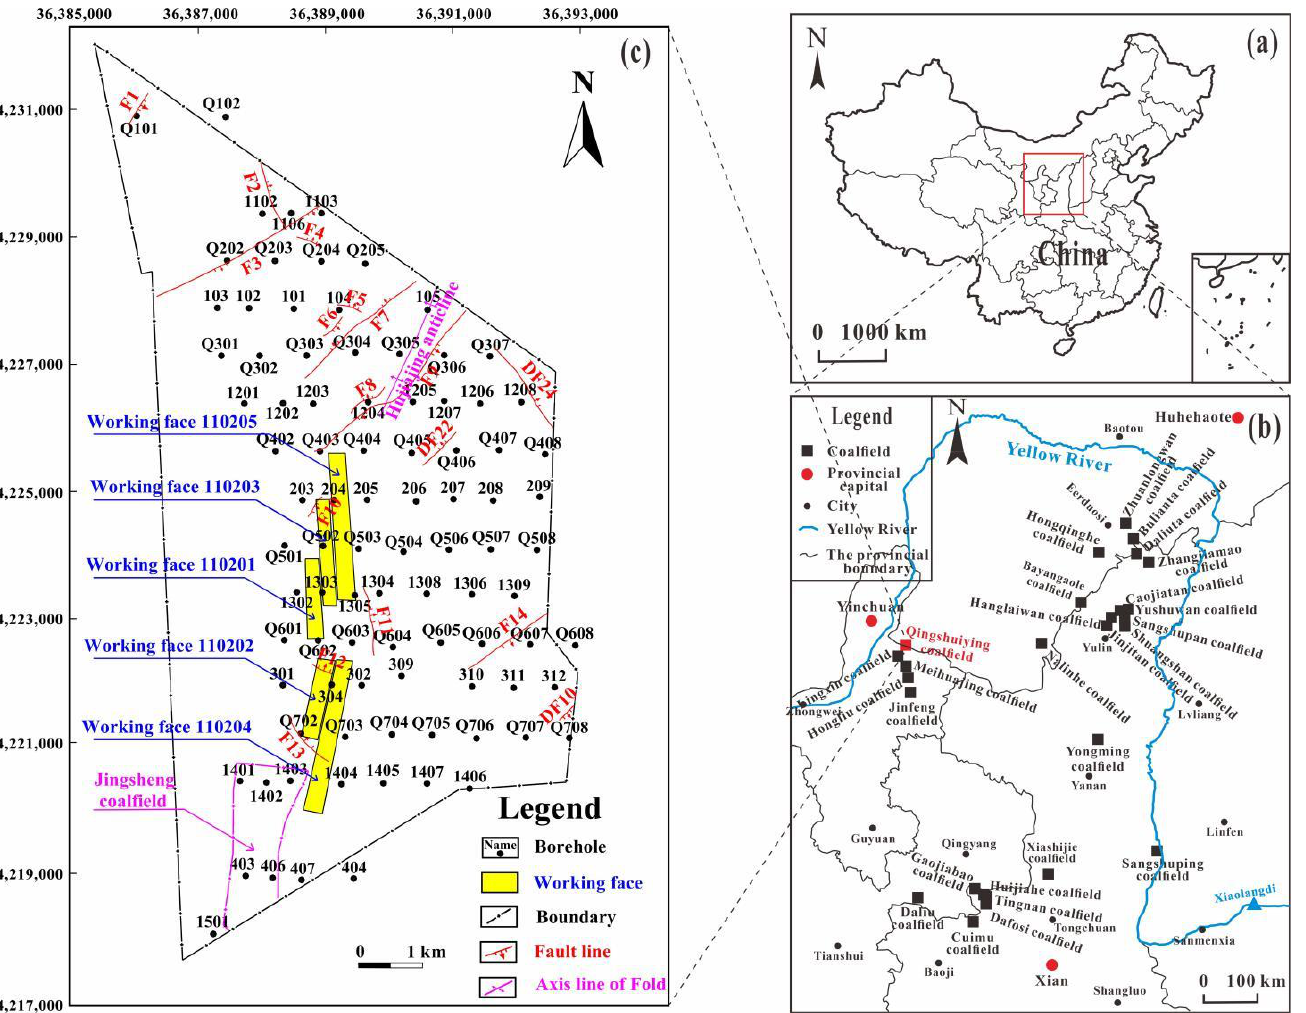
Figure 1. Location of study area: ( a ) Map of China, ( b ) Schematic diagram of location of each Coalfield, ( c ) Qingshuiying Coalfield.